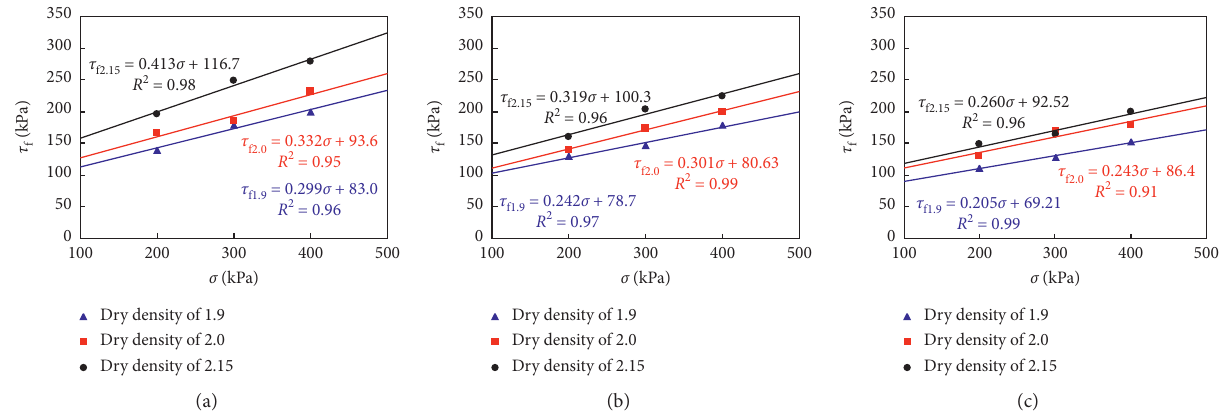
Figure 10: Shear strength composition of freeze-thaw interface in CGS. (a) w � 9.0%. (b) w � 11.5%. (c) w �